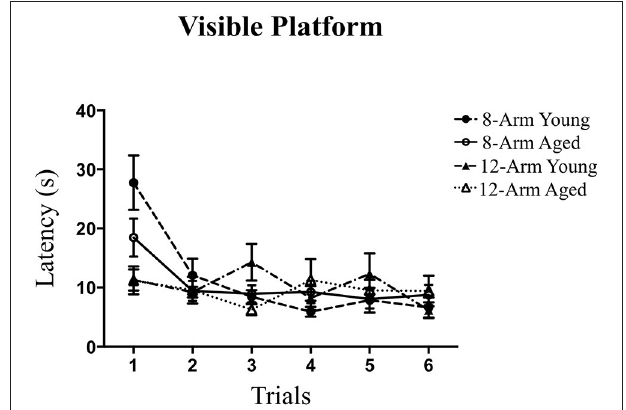
FIGURE 7 | Performance on the Visible Platform (VP) task. Latency (in seconds) across Trials 1–6 on the VP task, where groups did not differ in ability to perform the procedural components of a water escape